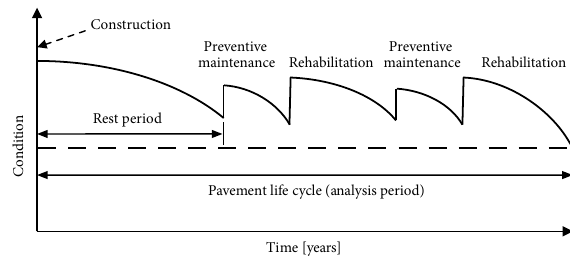
Fig. 1. Pavement rest